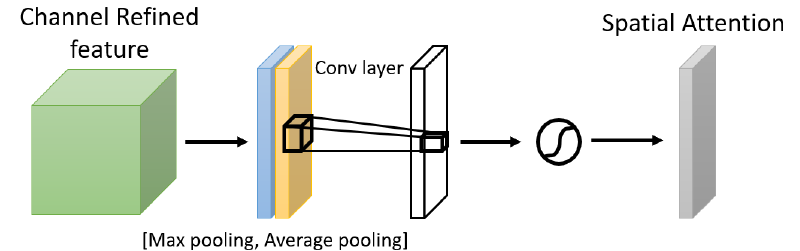
Figure 4. The Spatial Attention Submodule.